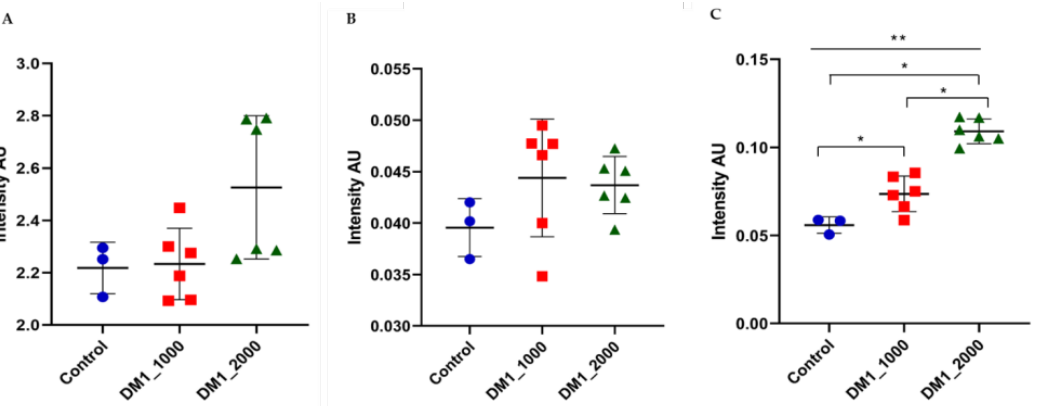
Figure 3. Scatter dot plot of DM1-derived fibroblasts and control ratios. ( A ) CH 2 /CH 3 ratio ( B ) Unsaturated/Saturated ratios of ( C ) Carbonyl/Total lipid ratio. * p ≤ 0.05; ** p < 0.0001, Control ( • ); DM1_1000 ( (cid:4) ); DM1_2000 ( (cid:78)